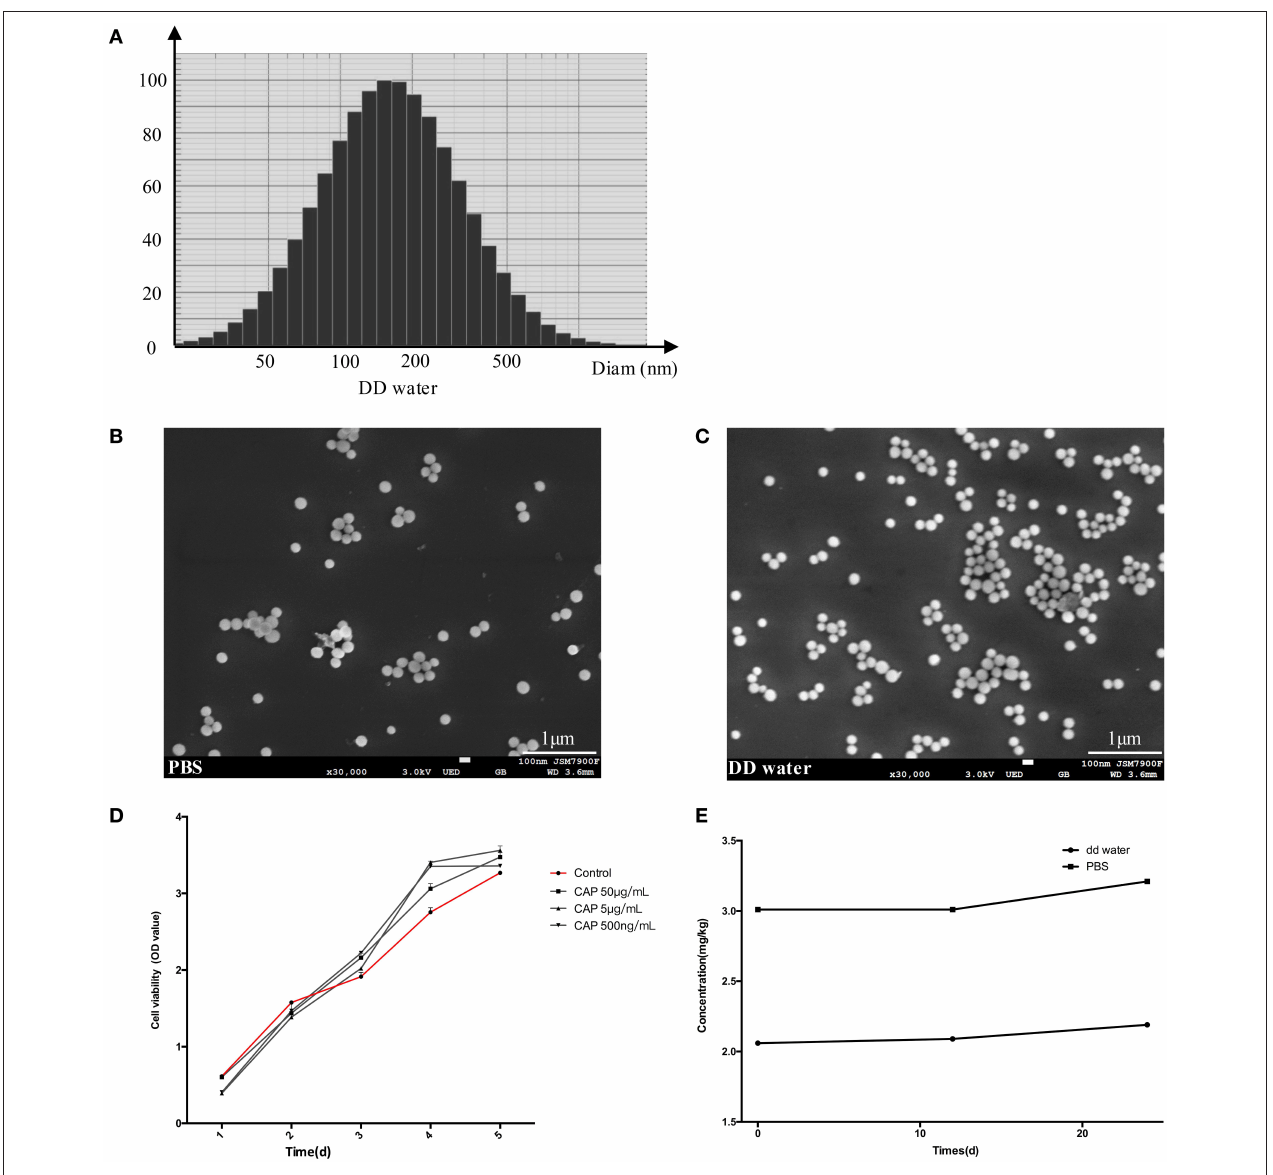
FIGURE 2 | The results of diameter scanning (A) and SEM (B,C) showed the physical properties of CL, which dispersed better in PBS (B) than DD water (C) . CCK-8 assay results (D) at 1, 3, 5, 7 days, showed that DPSCs grew stably after CL treatment. The ICP-AES analysis determined the concentration of calcium in CL (E) . CAP: calcium phosphate lipid